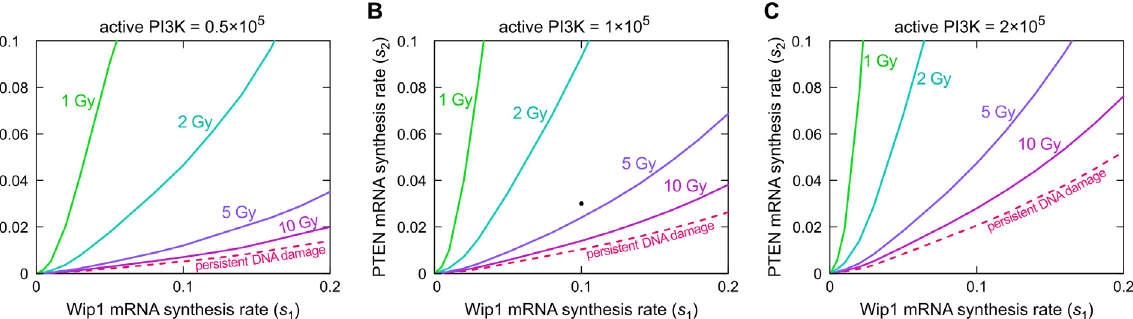
Fig 8. Critical irradiation doses as a function of Wip1 ( s 1 ) and PTEN ( s 2 ) mRNA synthesis rates. (A) Active PI3K level is decreased 2-fold from the nominal value. (B) The nominal value of active PI3K. (C) Active PI3K level is twice the nominal value. Color lines show the critical irradiation doses in the ( s 1 , s 2 )-parameter space. Dashed line corresponds to the persistent (irreparable) DNA damage equal 100 DSBs. For each dose, the line separates the apoptotic region (above the line) and the survival region (below the line) in the ( s 1 , s 2 )-parameter space. The black dot in (B) corresponds to nominal values of Wip1 and PTEN mRNA synthesis